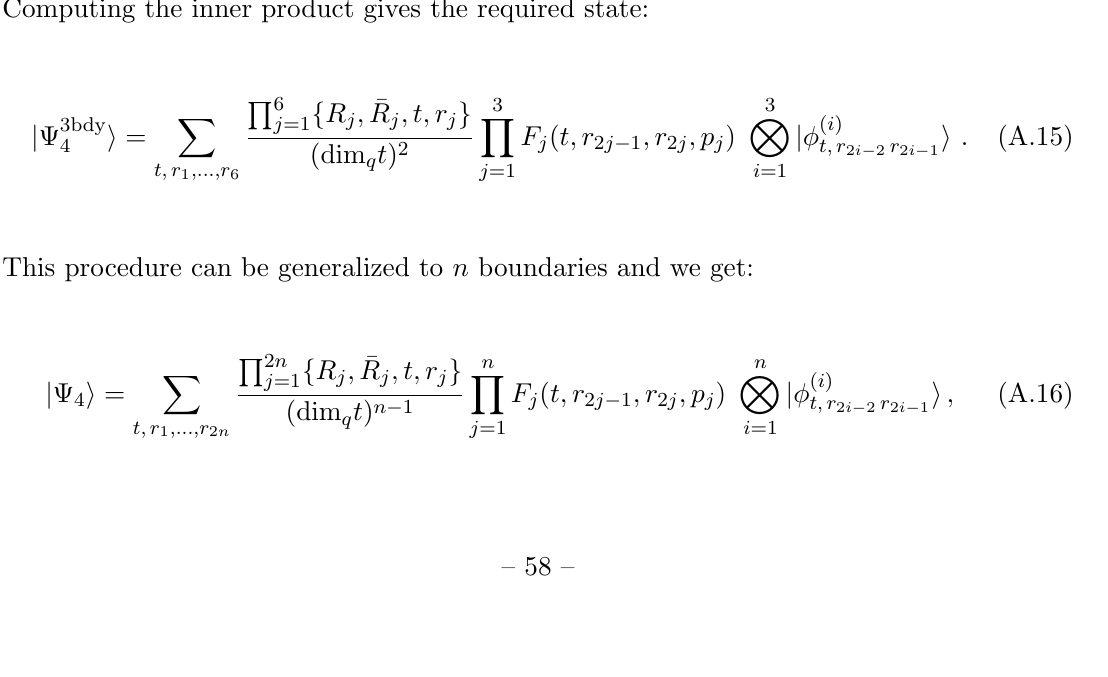
Figure 20 . Figure showing the construction of the state 5 and 6 are oppositely oriented compared to 4 , 5 and 6 respectively and can be glued together 4 (cid:31) , (cid:31) (cid:31) resulting in a three boundary